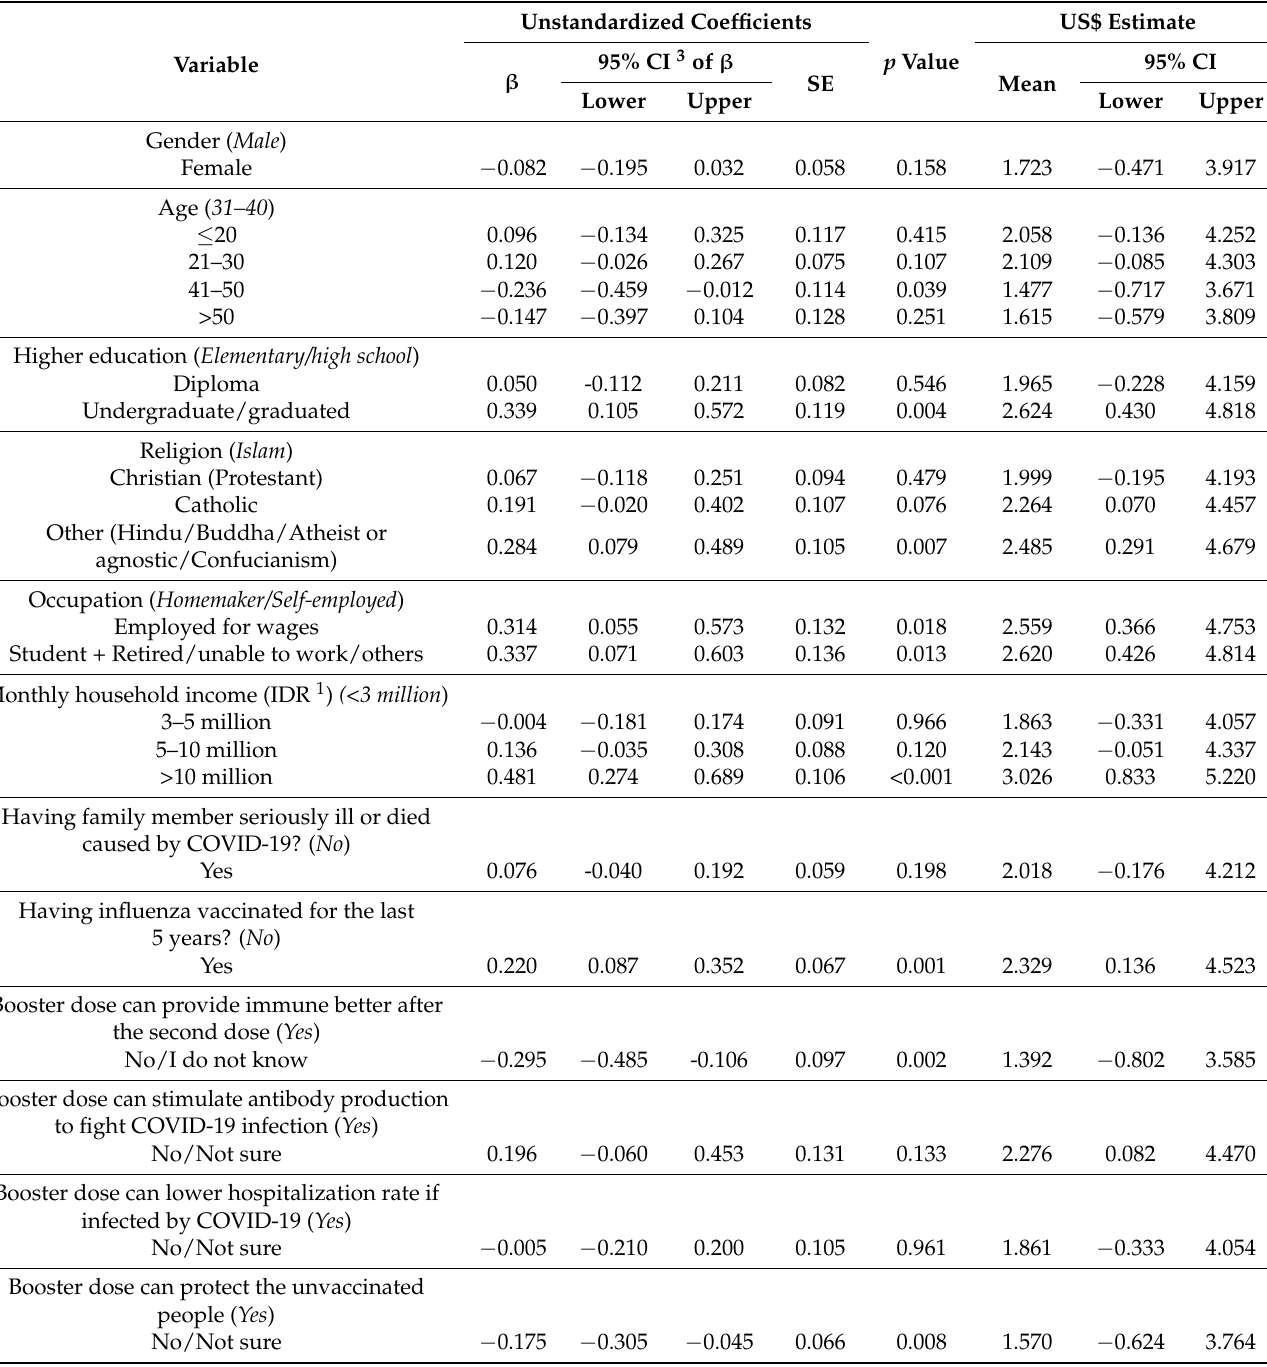
Table 4. Final multivariable linear regression model showing factors associated with the willingness- to-pay for a booster dose COVID-19 vaccine in Indonesia ( n =